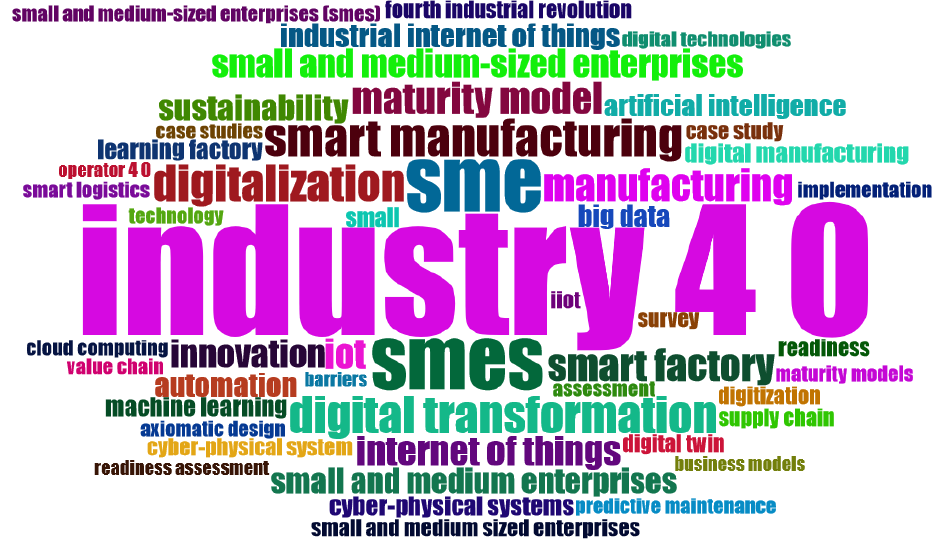
Figure 3. The cloud of keywords most frequently cited by the authors of the presented studies.